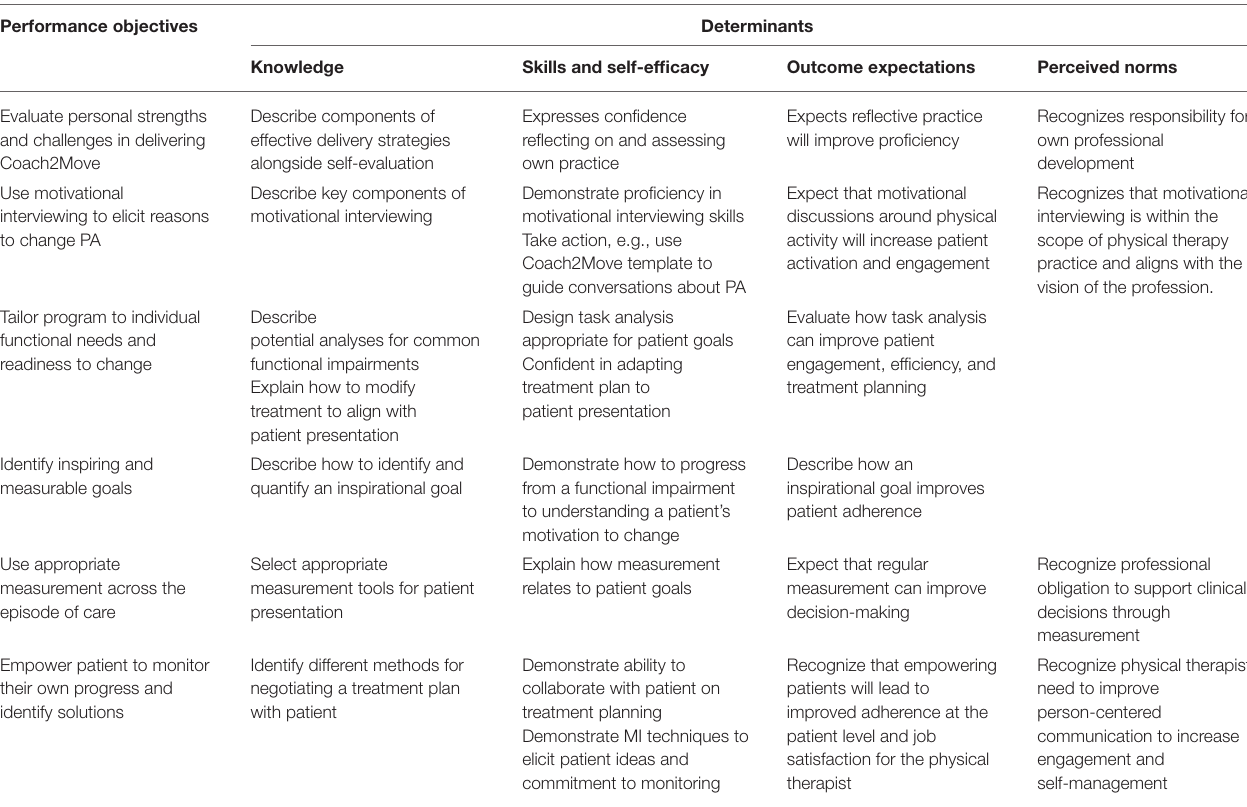
TABLE 4 | Matrices of change objectives for implementation of Coach2Move by physical therapists. Performance